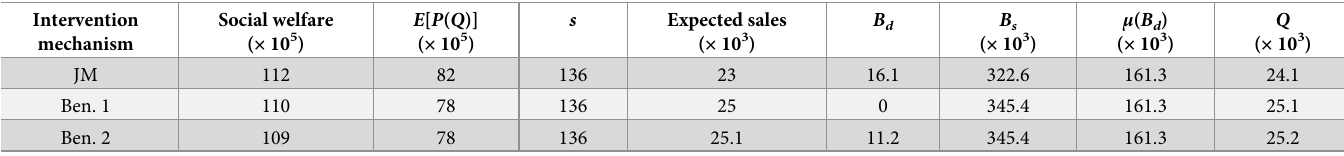
Table 5. The solutions of the long period given in exponential distribution. Intervention